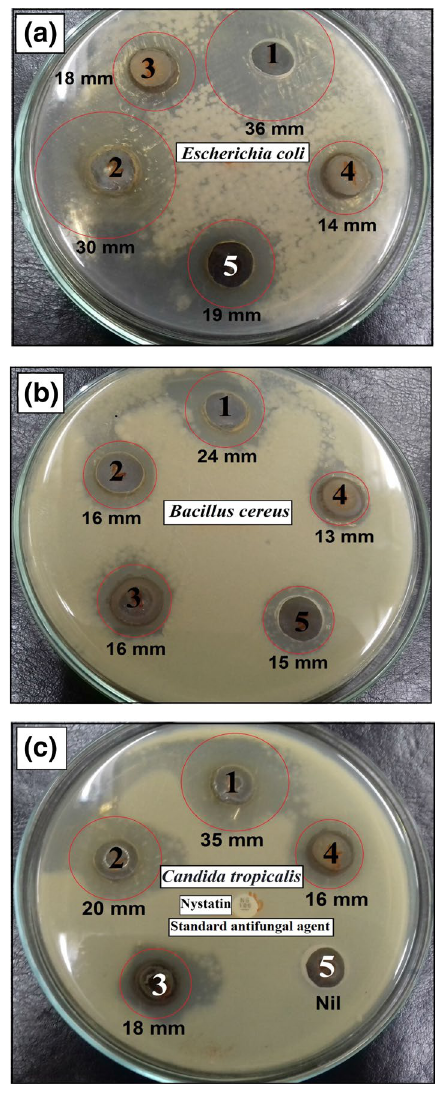
Figure 15. Antibacterial and antifungal activities of bare C-dots and Co x Ni 1−x Fe 2 O 4 ; x = 0.9/SiO 2 /TiO 2 /C-dots nanocomposite on: ( a ) Escherichia coli , ( b ) Bacillus cereus and ( c ) Candida tropicalis measured as ZOI (mm). 1 = Co x Ni 1−x Fe 2 O 4 ; x = 0.9/SiO 2 /TiO 2 /C-dots nanocomposite (15 µg/ml), 2 = Co x Ni 1−x Fe 2 O 4 ; x = 0.9/SiO 2 /TiO 2 /C- dots nanocomposite (10 µg/ml), 3 = bare C-dots (15 µg/ml), 4 = bare C-dots (10 µg/ml) and 5 = Amoxicillin/ Clavulanic Acid (100 µg/ml, standard antibacterial